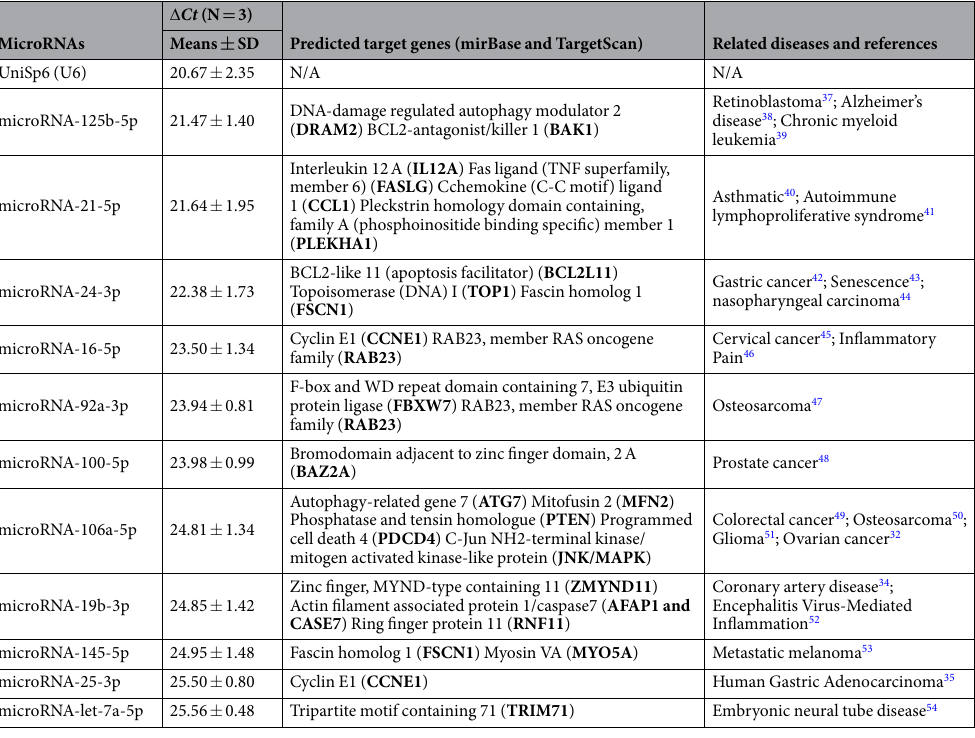
Table 1. Predicted target genes analysis of microRNAs expressed in